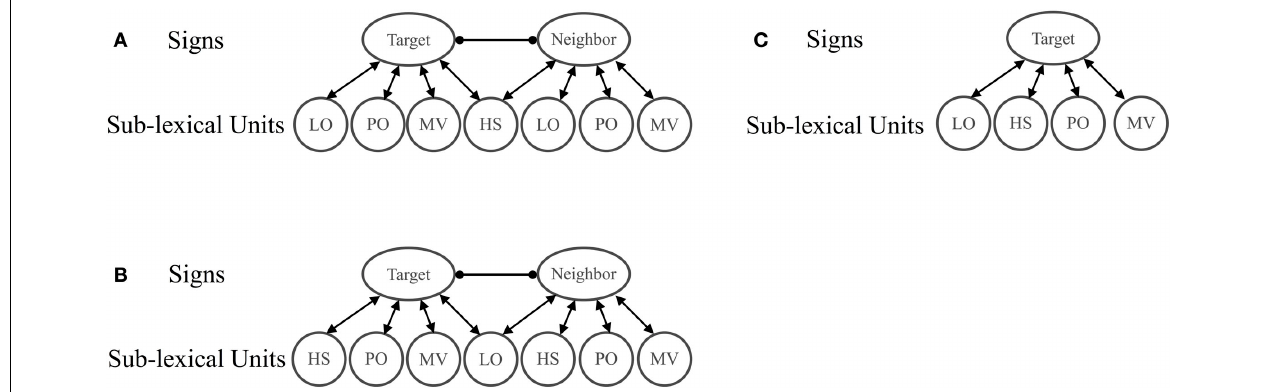
(A,B) became active more quickly than the target item without a neighbor (C) . Neighbors were considered to have an inhibitory effect if the target item with a neighbor became active more slowly than the target item without a neighbor.